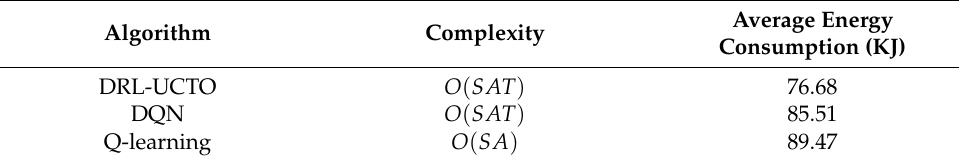
Table 3. Comparison of DRL-UCTO with other reinforcement learning